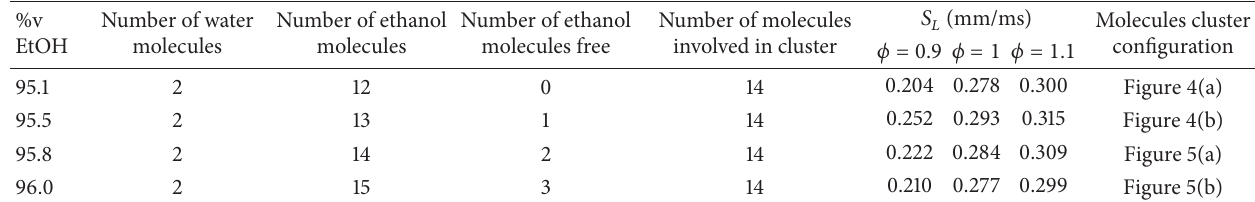
Table 1: The relationship between ethanol composition, number of water molecules, number of ethanol molecules, and laminar burning